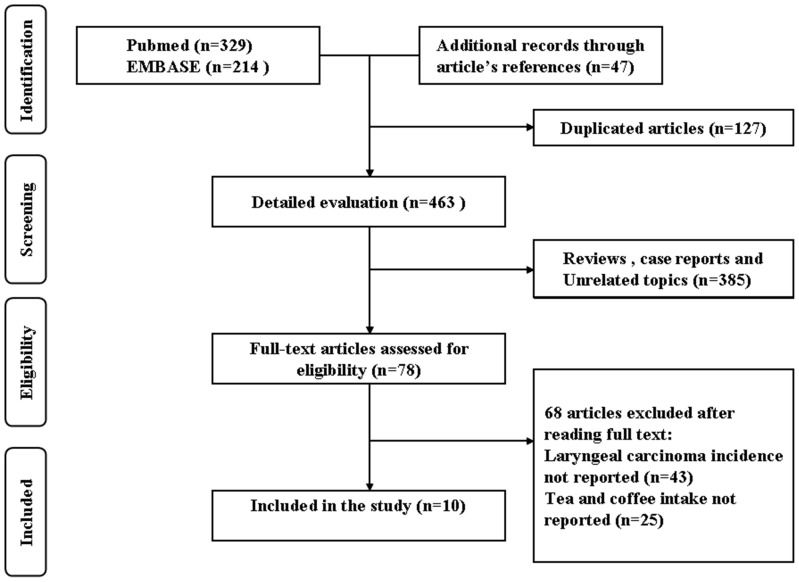
Flow diagram of screened, excluded, and analysed publications.